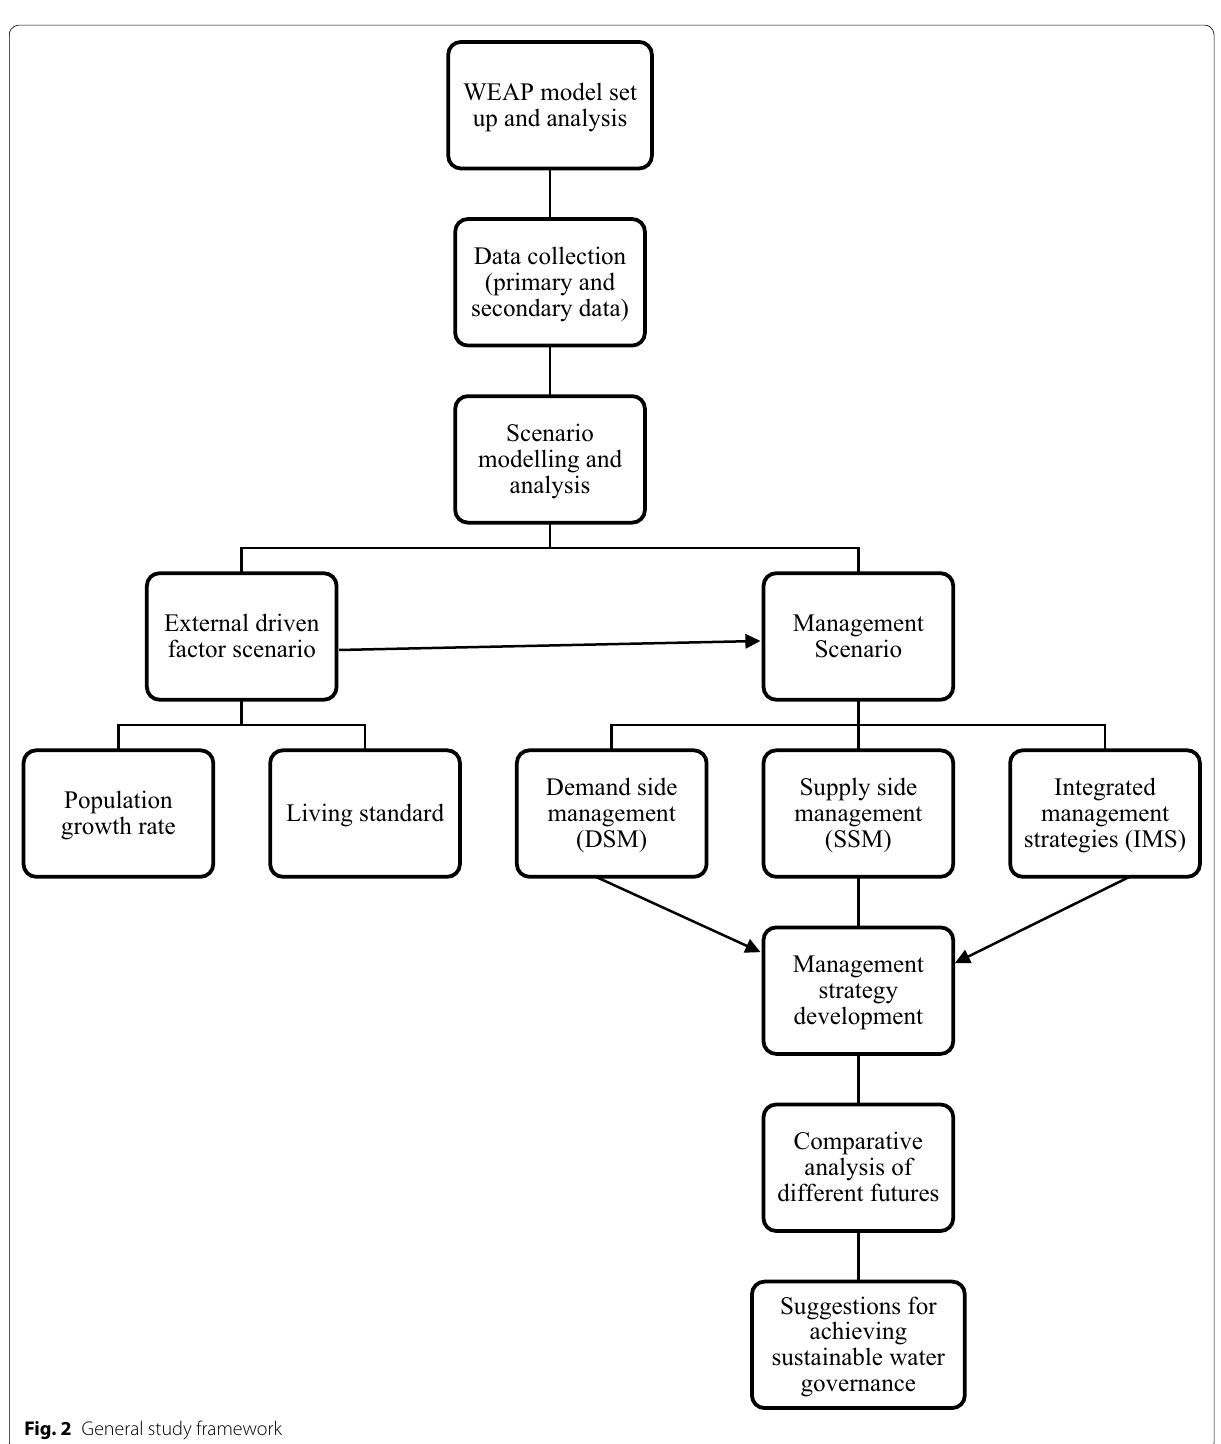
Fig. 2 General study